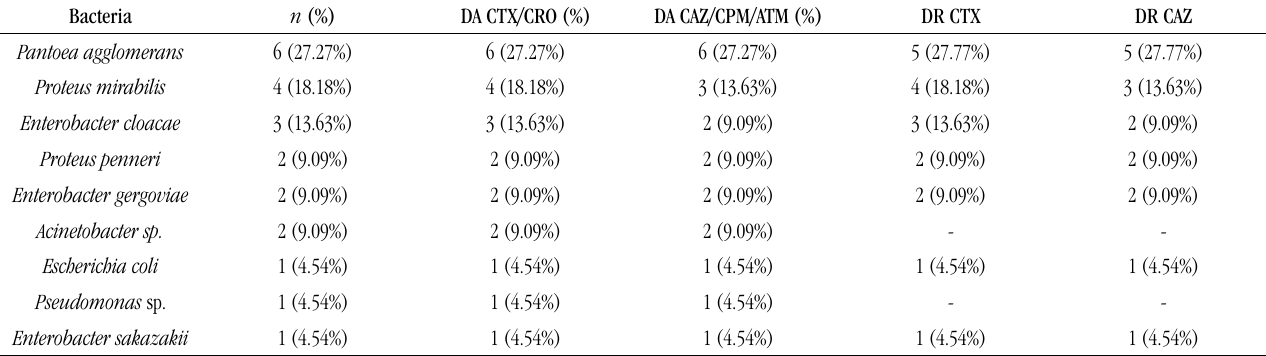
tABLE – ESBL detection results in positive strains for enzyme using the disc approximation and disc replacement methods